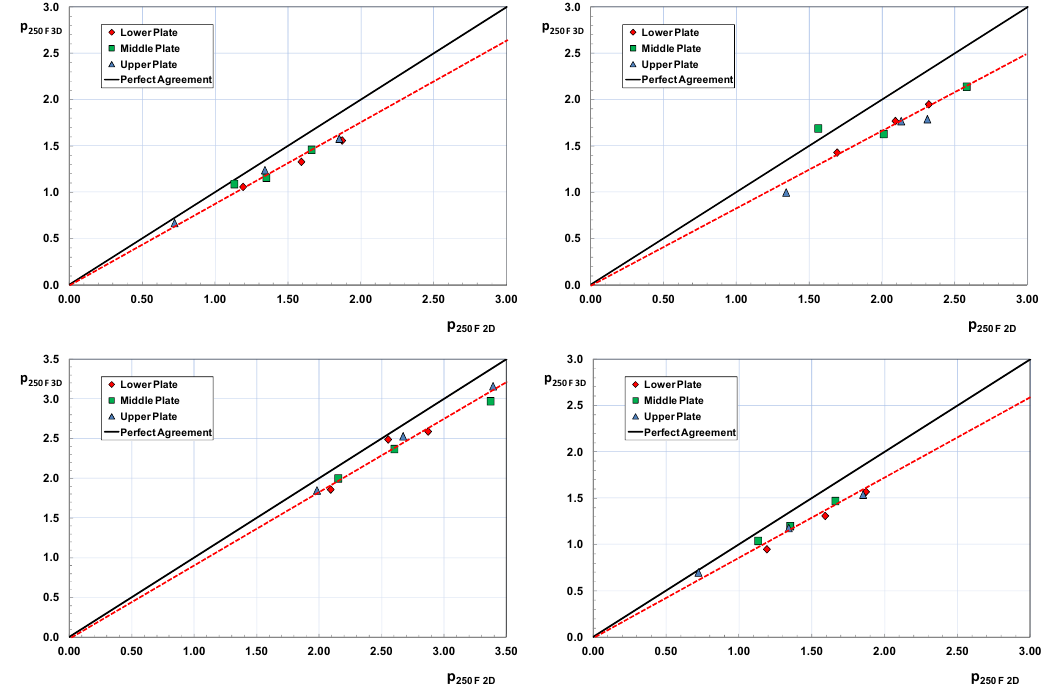
Figure 22. Effect of the spreading index (degree of short-crestedness). Data refer to couple of tests that differ only by the value of n ( n = 10 in abscissas, n = 4 in ordinates). Top panels (front waves): left: H panels (side waves): left: H